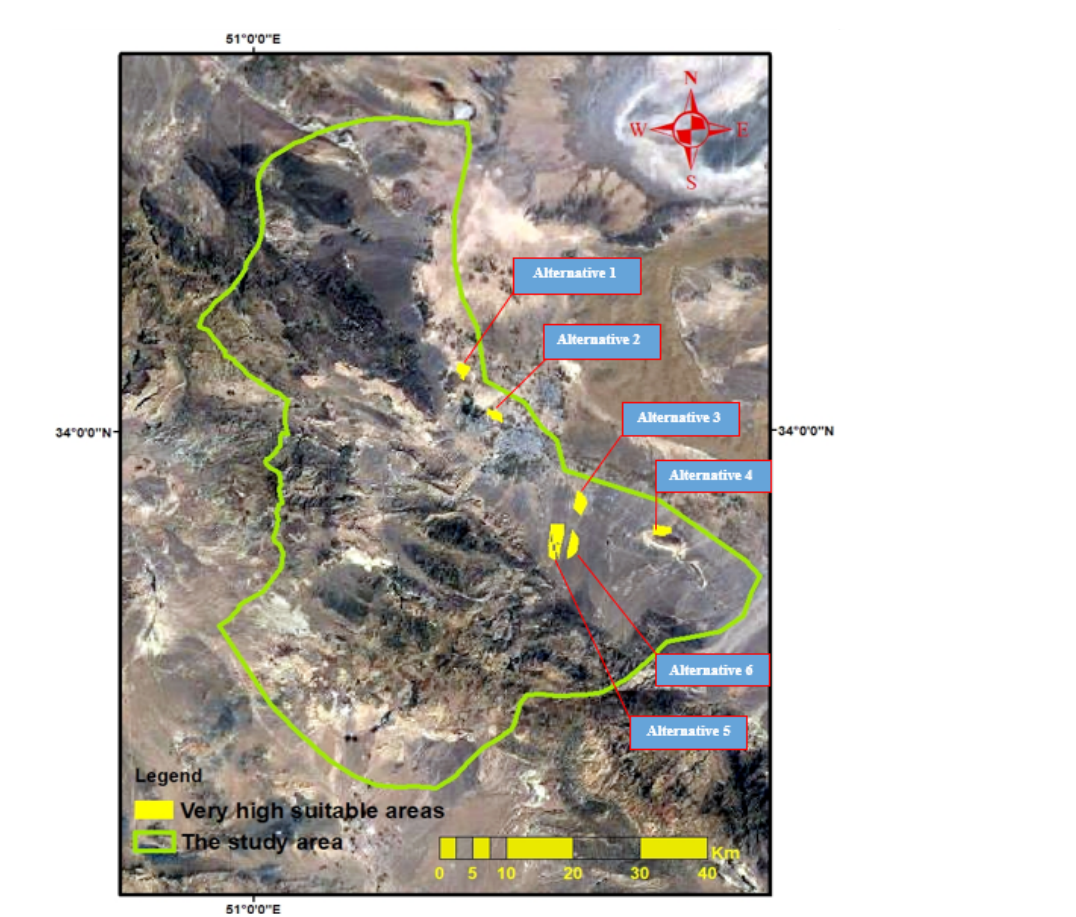
Figure 2. The location of suitable areas for the establishment of industries in Kashan City